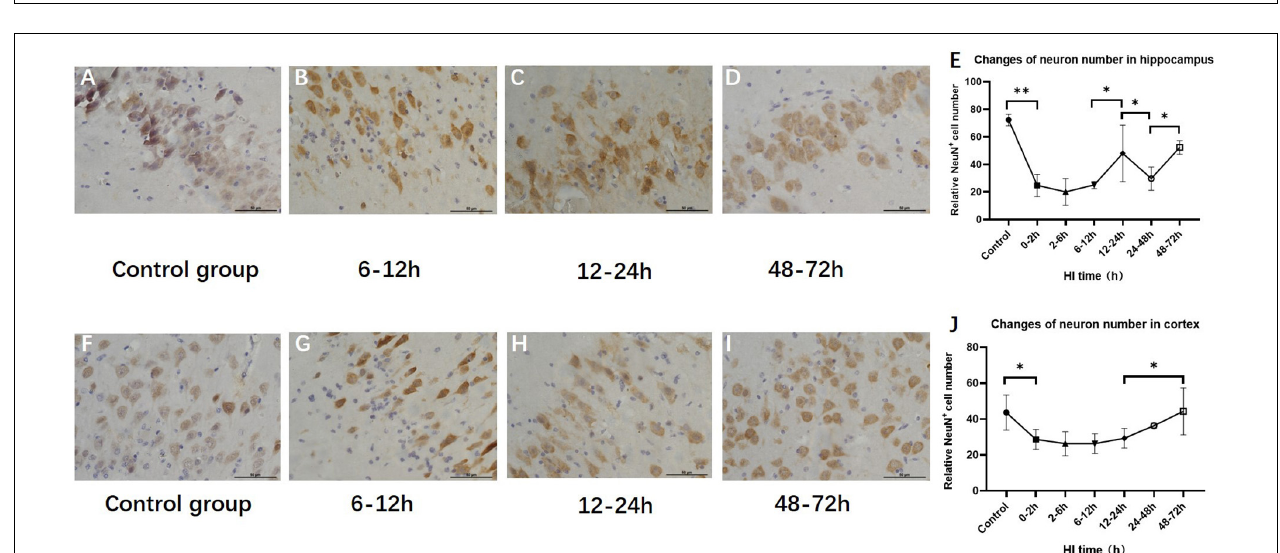
FIGURE 5 | Changes in the number of NeuN-positive cells in the hippocampus and cortex after HI ( × 400). (A) NeuN immunohistochemical staining of the hippocampus in the control group. (B–D) NeuN immunohistochemical staining of the hippocampus in HI groups at 6–12, 12–24, and 48–72 h after HI. (E) The number of NeuN-positive cells in the hippocampus decreases at 0–12 h and significantly increases at 12–24 h after HI injury. (F) NeuN immunohistochemical staining of the cortex in the control group. (G–I) NeuN immunohistochemical staining of the cortex in groups at 6–12, 12–24, and 48–72 h after HI. (J) Compared with the control group, there is a significant decrease in the number of NeuN-positive cells in the cortex at 0–2 h after HI injury, and the number of NeuN-positive cells at 48–72 h after HI is significantly increased. ∗∗ P < 0.01, ∗ P < 0.05; data are expressed as mean ±